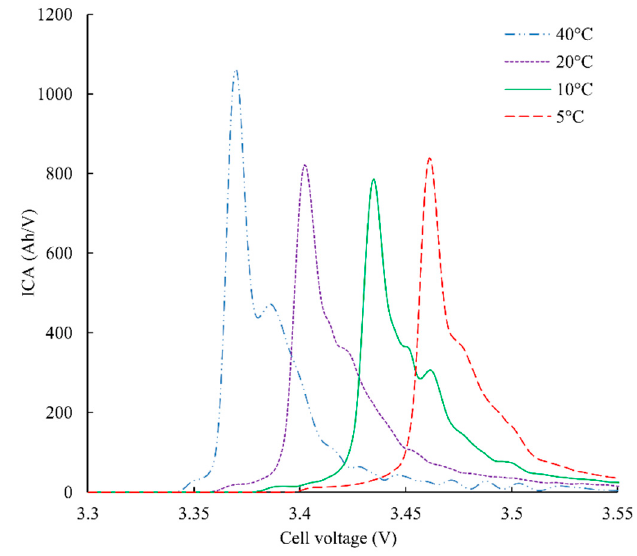
Figure 11. Temperature impact on ICA with pause prior to peak 2 (C/3-100% DoD-SoH 80%).